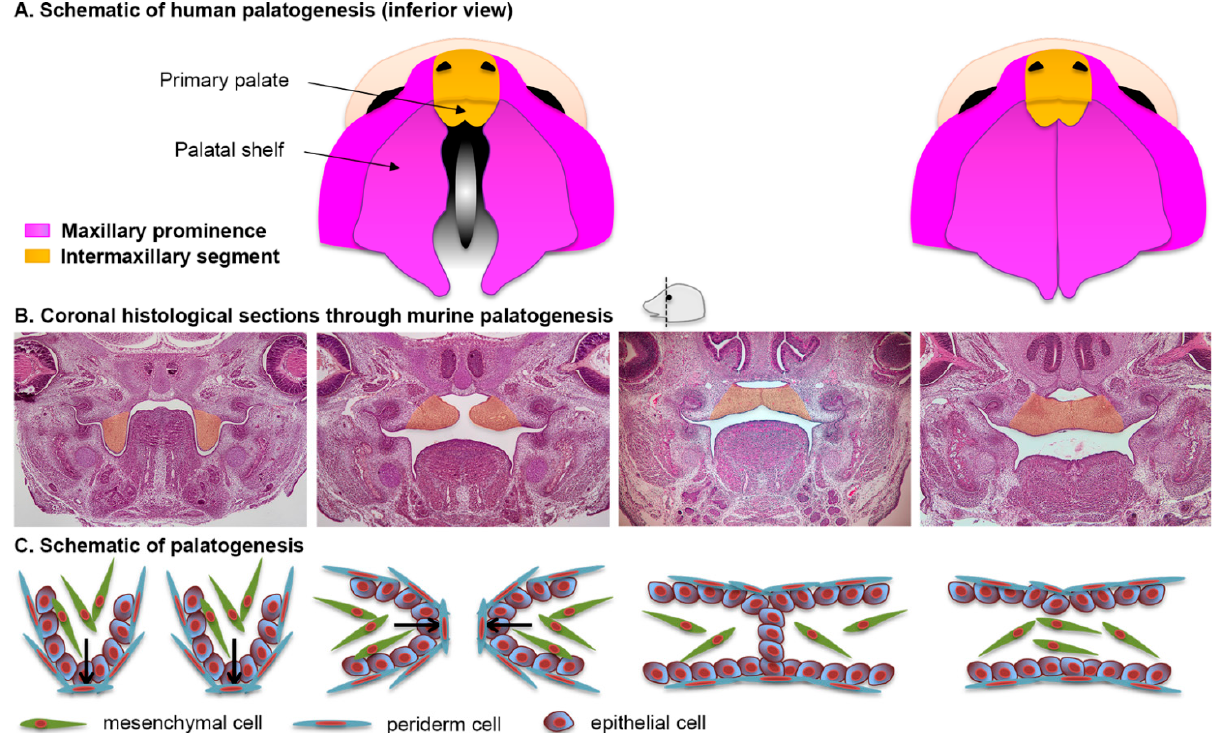
Figure 3. Palatal morphogenesis . ( A ) Schematic of human palatogenesis from an inferior view. ( B ) Coronal sections of murine embryonic heads stained with hematoxylin and eosin. The palatal shelves, highlighted in orange, change from a vertical position (approximately E13.5) to a horizontal position (approximately E14); their epithelial cells adhere to eventually leave a confluent bridge of mesenchymal cells (approximately E15). ( C ) Schematic representation of the histological views in ( B ).